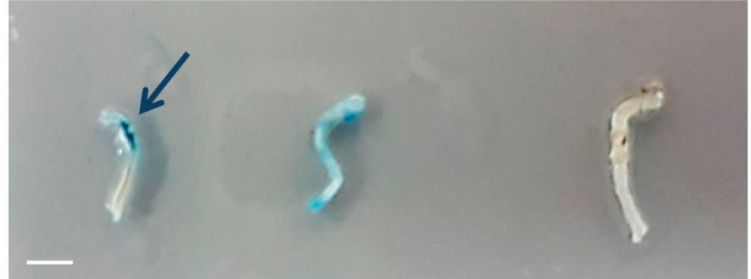
Figure 6. In vivo magnetic targeting in sciatic nerve model. Images of extracted sciatic nerves: Left : nerve injected with MNPs. A magnet tip was placed externally following injection, leading to MNPs accumulation near magnet (stained in blue). Middle : nerve injected with MNPs, without an external magnet. MNPs are distributed along the nerve. Right : Control (no injection of MNPs). Scale bar = 4